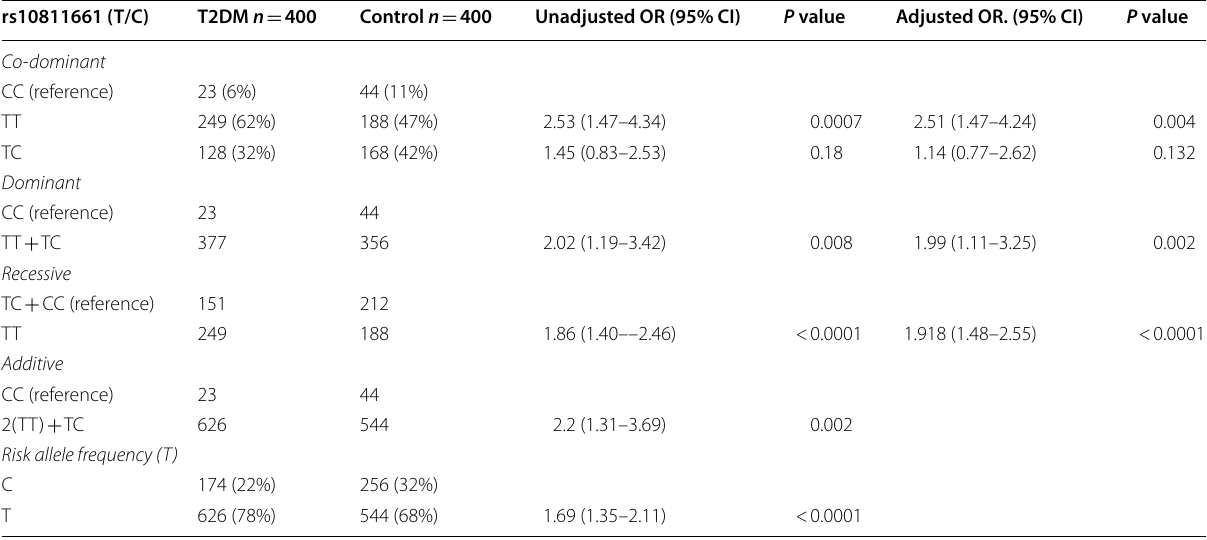
Table 2 Distribution of genotypes and allele frequency in CDKN2A/B gene polymorphism (rs10811661) for T2DM and control subjects rs10811661 (T/C)